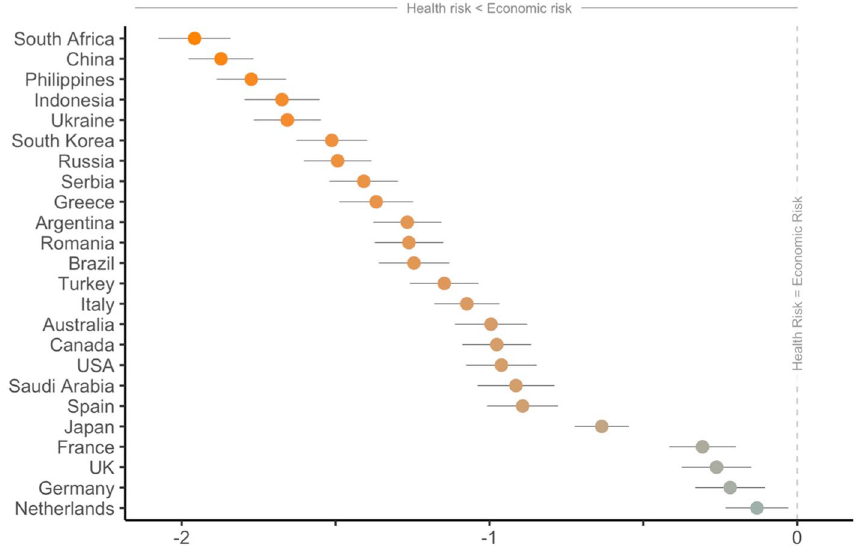
Figure 2. Mean difference between perceived health risk and perceived economic risk. Note : Standardized Mean Difference, Error Bars 95%